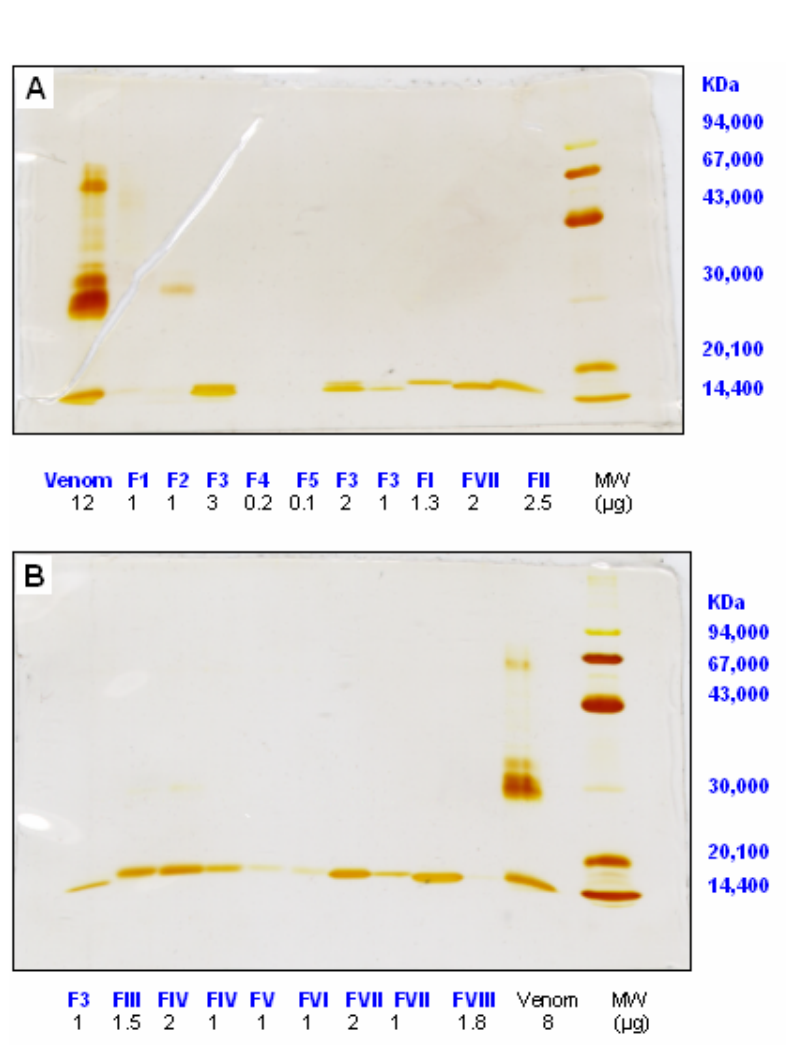
Figure 3. Electrophoresis of the fractions obtained in the isolation of PLA asper snake